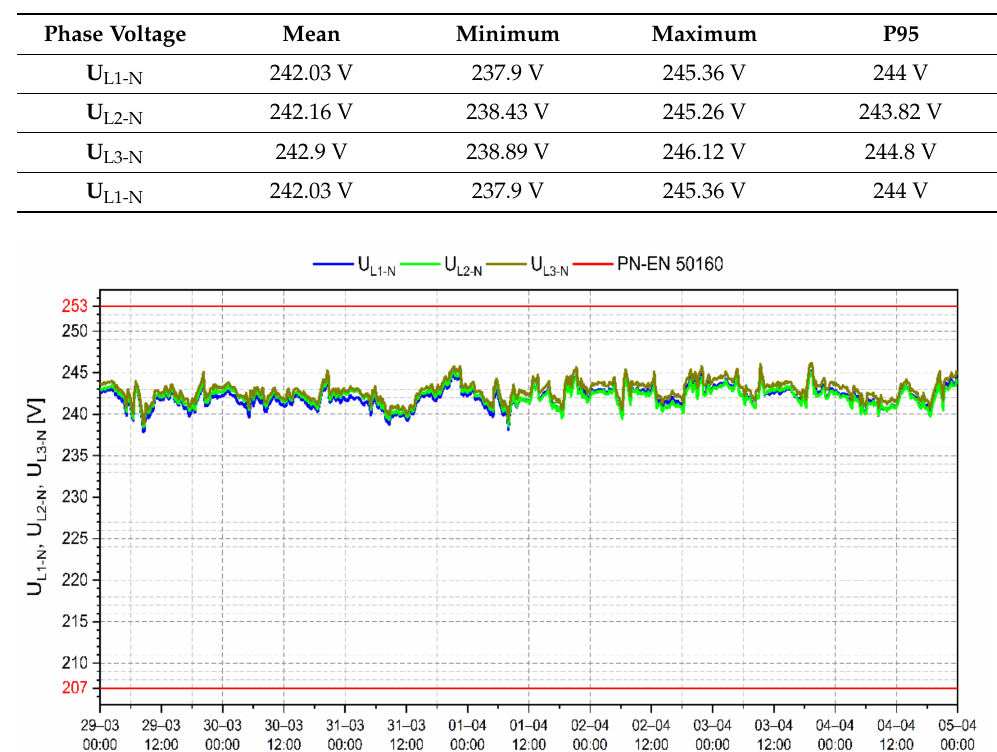
Table 1. Phase voltage values for the one-week measurement period.